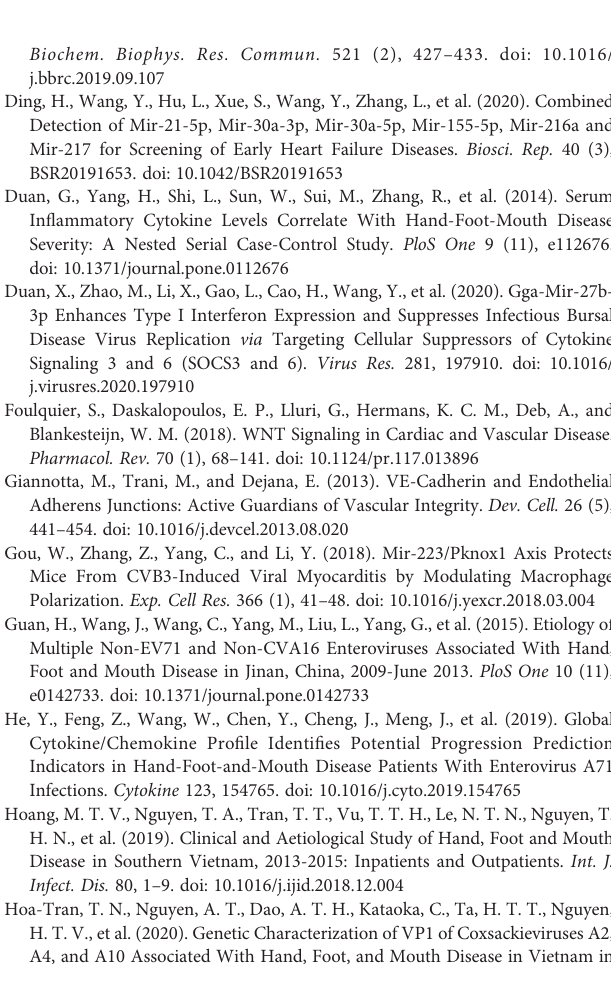
Supplementary Table 3 | Differentially expressed miRNAs at 7 dpi Supplementary Table 4 | Differentially expressed miRNAs (7 dpi vs 3